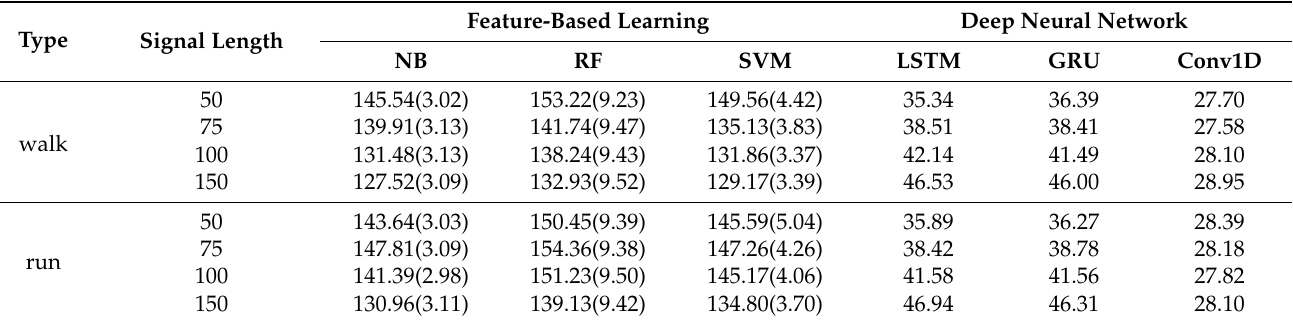
Table 5. Average elapsed times in milliseconds for inferencing test data with a batch size of 100. For the feature-based learning, elapsed times for feature extraction are included. Average inference time is displayed in parentheses after individual